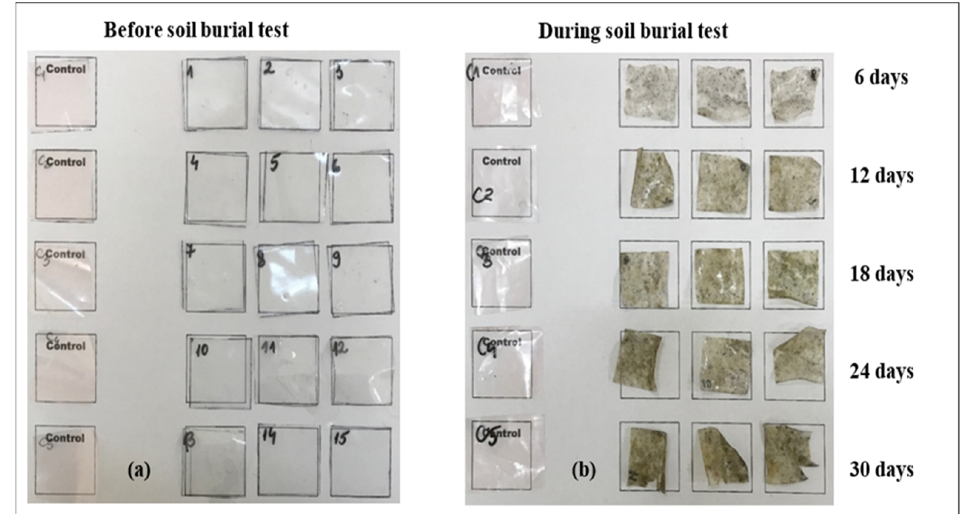
Figure 5. The physical appearance of CSH film samples and control samples before ( a ) and during ( b ) the soil burial test. ( b ) the soil burial